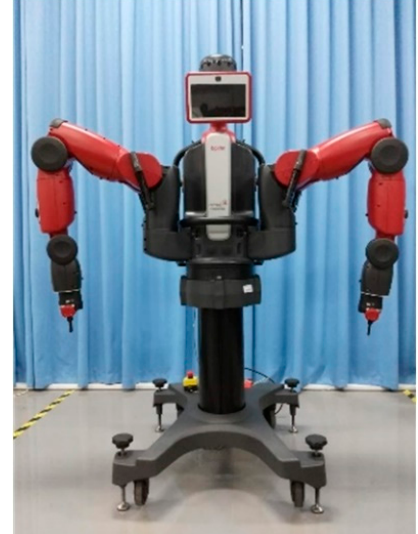
Figure 1. Baxter research robot.